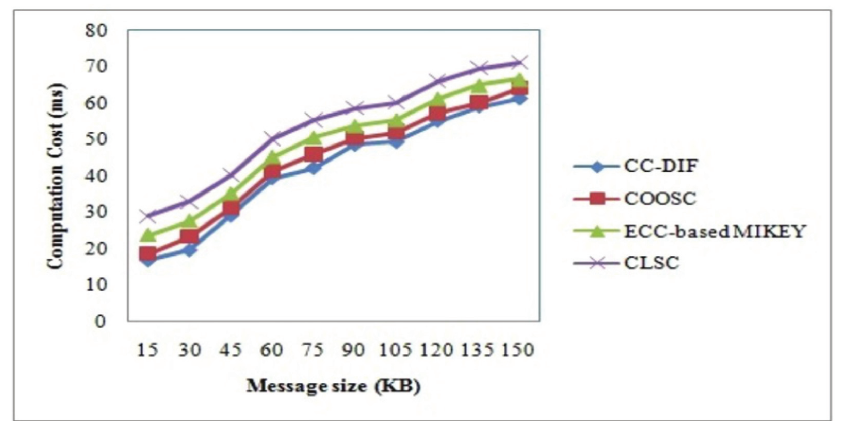
Fig 3. Computation cost of CC-DIF and three existing methods.